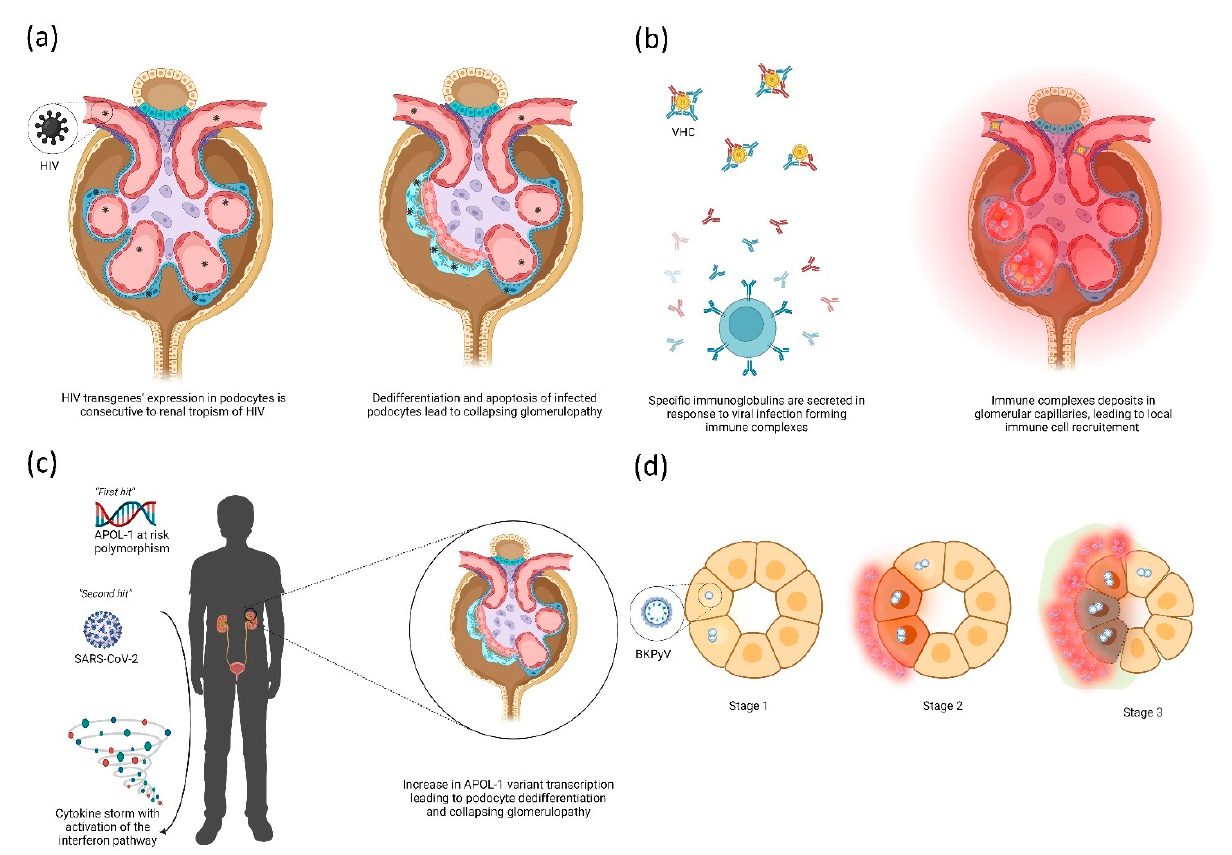
Figure 1. Main representative direct ( a and d ) and indirect ( b and c ) mechanisms observed in viral nephropathies. ( a ) Podocyte infection by HIV leads to expression of HIV transgenes which promote dedifferentiation and vacuolization of podocytes. Abnormal podocytes detach from the glomerular basement membrane, leading to collapse of the capillary coves and flocculus. ( b ) The B cell-mediated reaction to viral infection, especially during HCV, can lead to the production of immune complexes consisting of specific IgG and IgM that fix viral particles, possibly with a cryoglobulinemic property. These complexes will further disseminate through the whole organism, and notably throughout the glomerular capillaries where they induce neutrophil and T cell recruitment, leading to the MPGN pattern. ( c ) Patients with the APOL-1 at-risk polymorphism carry a risk of collapsing glomerulopathy, especially if a “second” hit occurs involving the interferon pathway. The APOL-1 variant transcript is thus increased, leading to podocyte differentiation and progression to collapsing glomerulopathy. ( d ) Epithelial renal tubular cells are infected with BKPyV, leading to intranuclear viral inclusions (Stage 1), further evolving towards cytoplasmic modifications with a local immune reaction (Stage 2) and finally cell apoptosis and fibrosis (Stage